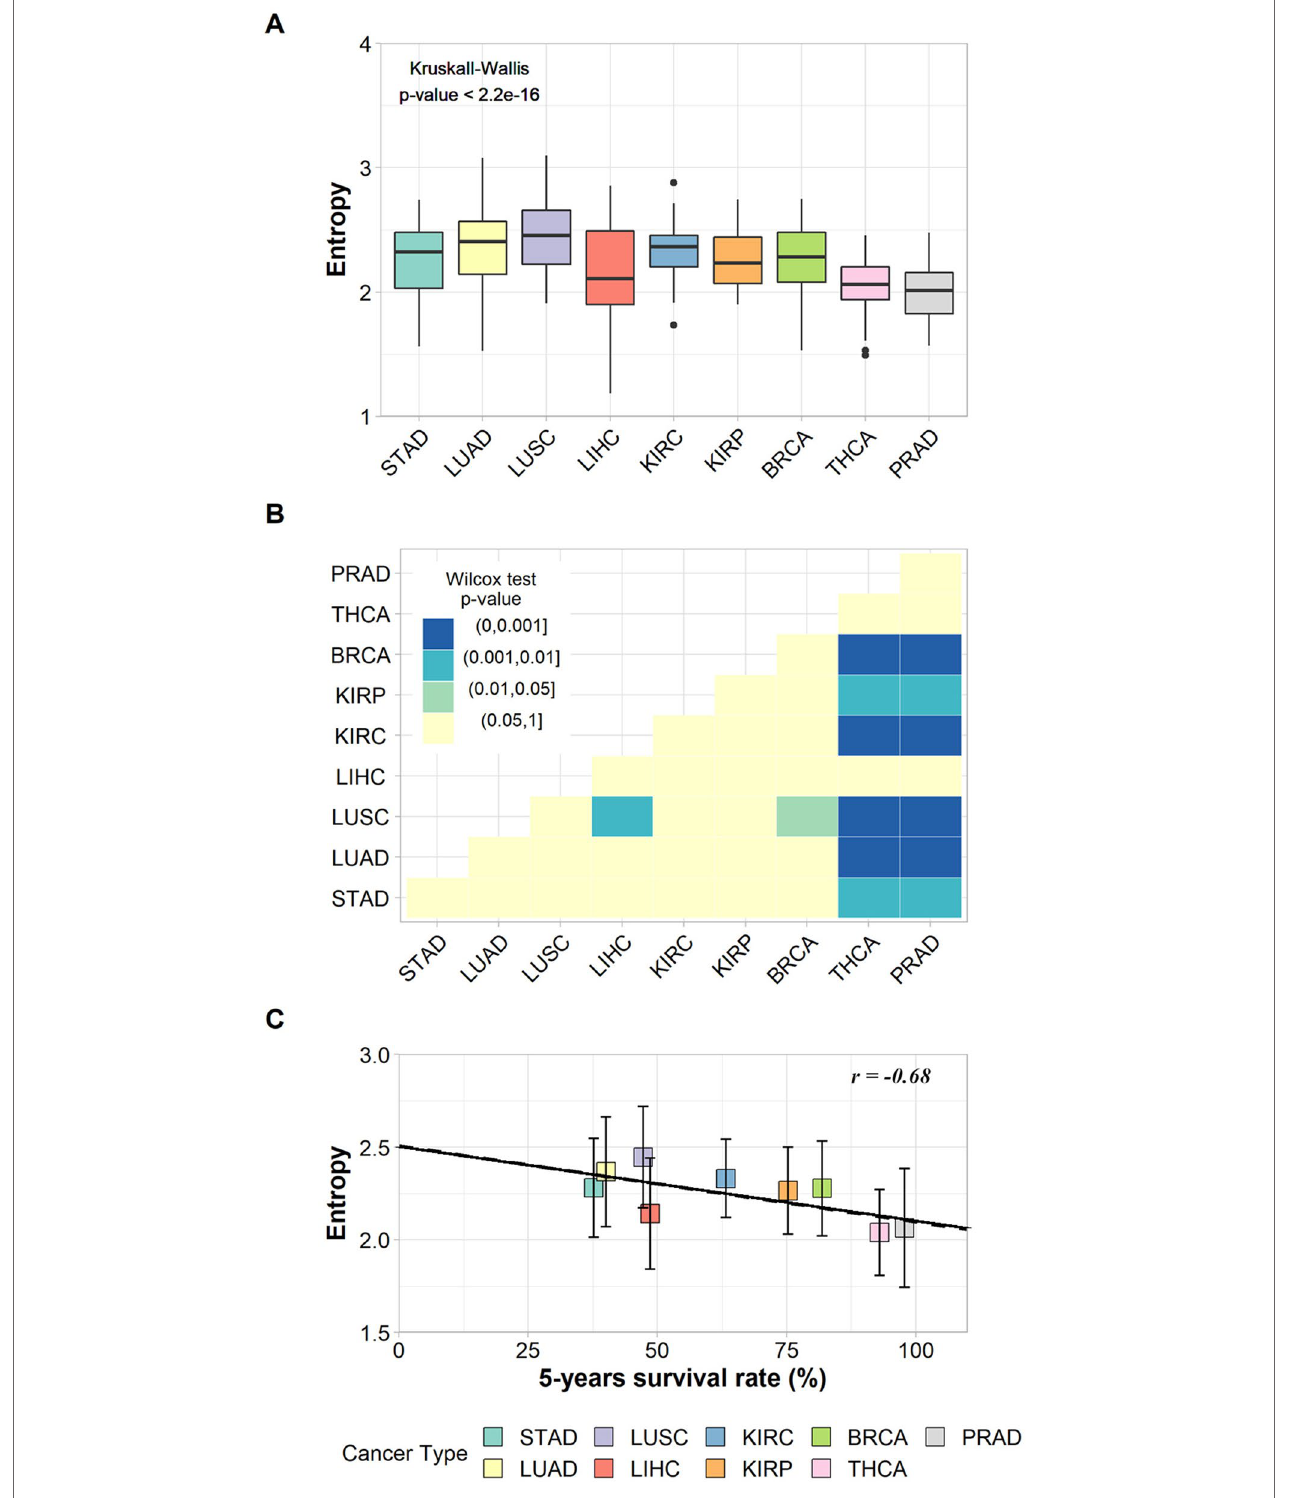
FIGURE 2 | (A) Box plot of the entropies found for the subnetworks of up-regulated genes in each cancer type and the result of Kruskal–Wallis test. (B) Heat map of p -values from Wilcoxon pairwise comparison. Light-yellow squares represent non-significant p -values; other colors represent significant but different p -values according to legend. (C) Correlation between entropies of up-regulated genes’ subnetworks and their respective 5-year survival rates. The vertical bars indicate standard